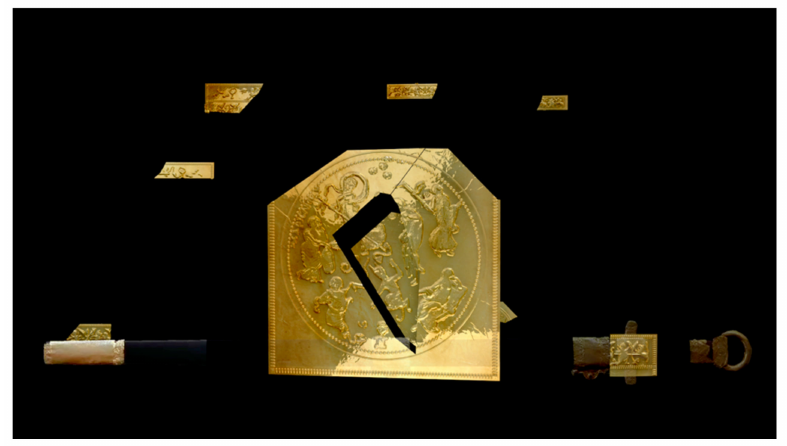
Figure 10. Virtual reconstruction of the process of breaking and reuse of golden sheets that were originally applied to a Byzantine object to decorate the scabbard of the kun à gota sword.